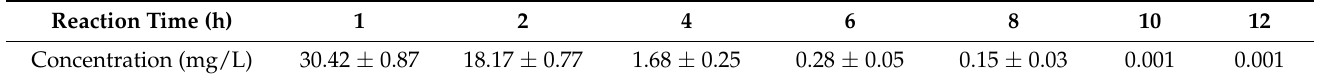
Table 7. Variation of Pb concentration in wastewater with reaction time (mg/L).